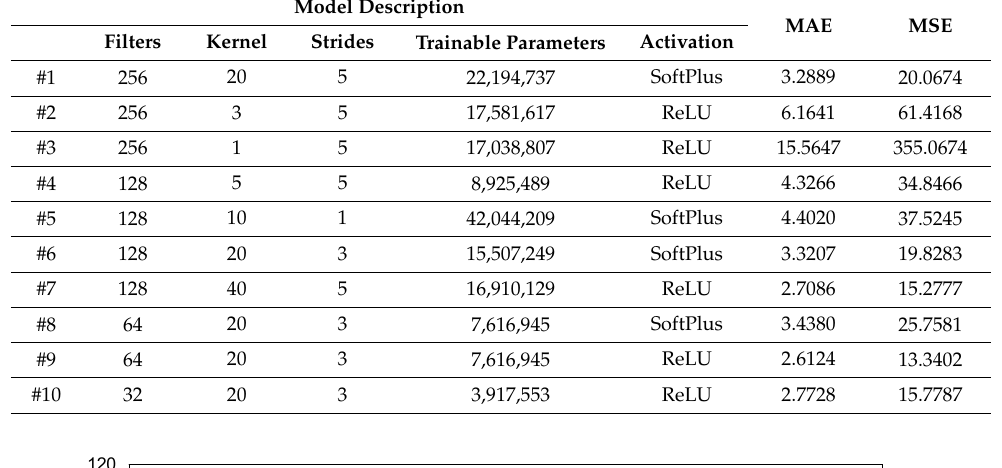
Table 4. Parameter optimization for ConvLSTM models.